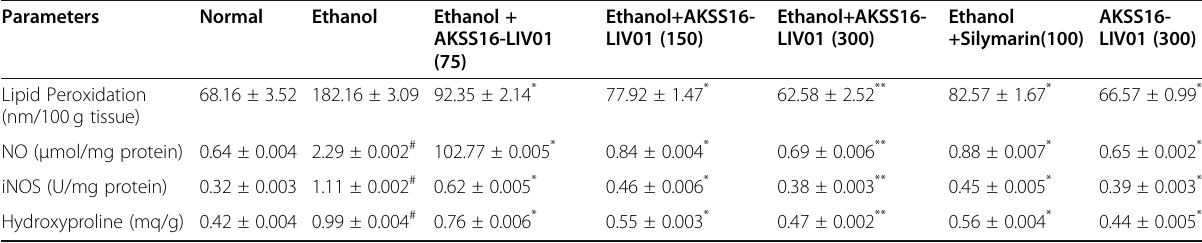
Table 8 Effect of AKSS16-LIV01 onliver Lipid peroxidation, NO, iNOS levels and Hydroxyproline concentration in chronic ethanol- induced hepatic damage in mice